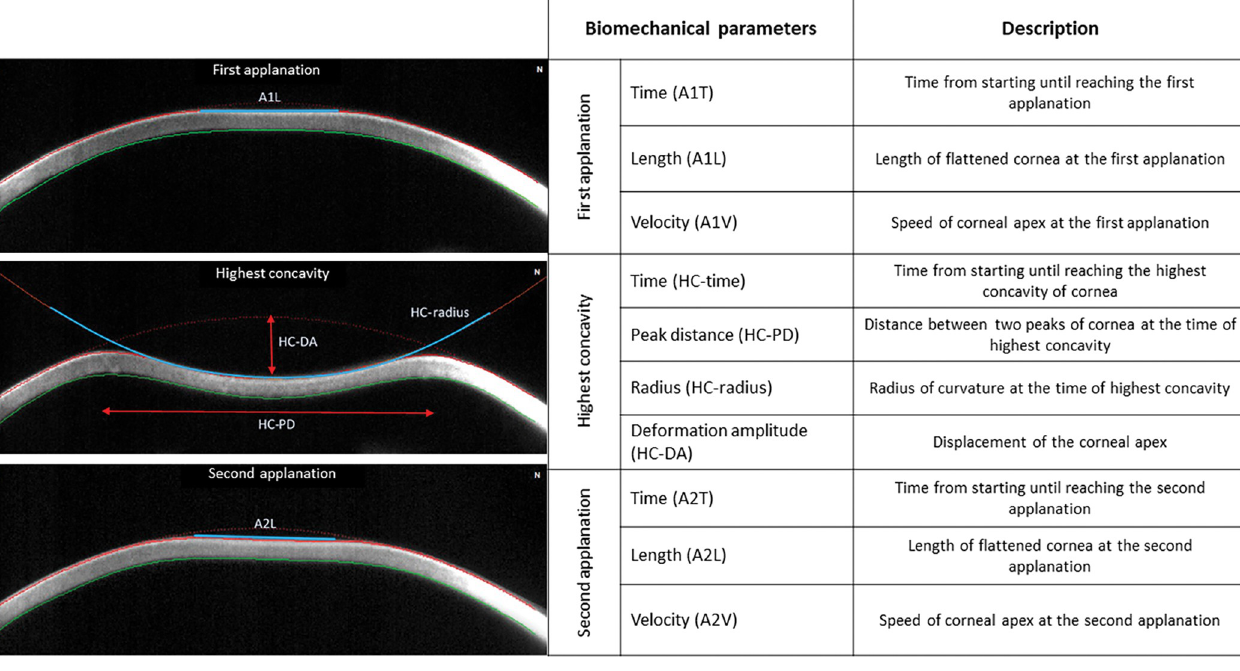
PLOS ONE | https://doi.org/10.1371/journal.pone.0254442 July 12,